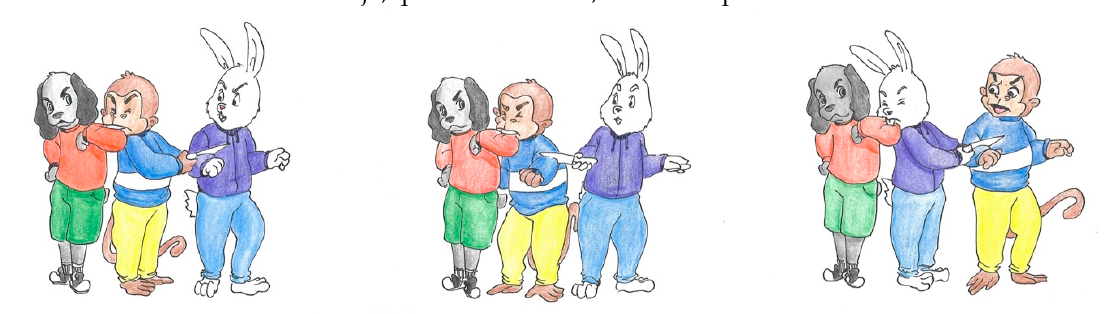
Figure A14. SRC stimulus 9.